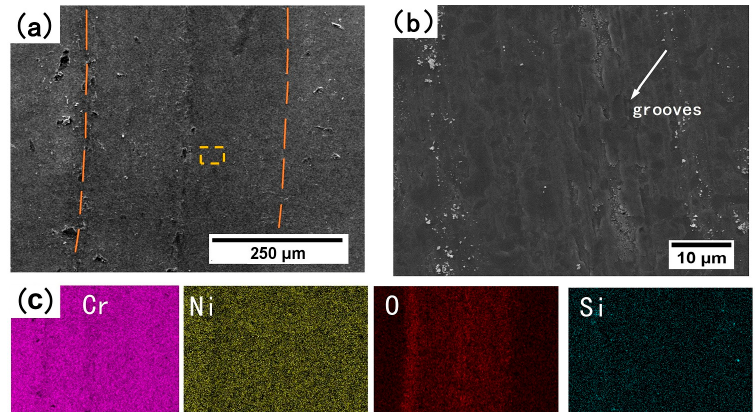
Figure 11. ( a ) Surface morphology of the wear scar (the region between two dash lines) of the as-sprayed coating after wear test at 600 °C; ( b ) high-magnification image of the selected region marked by the dashed rectangle in ( a ); ( c ) EDS elemental mapping of Cr, Ni, O and Si of ( a ).